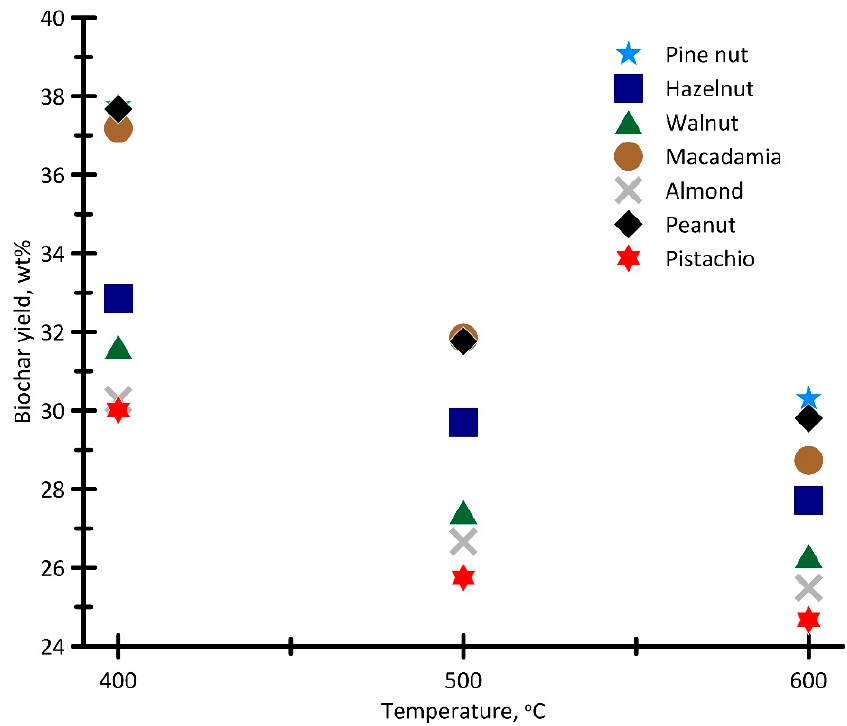
Figure 4. Dependence of changes in the biochar yield on the heating medium temperature.